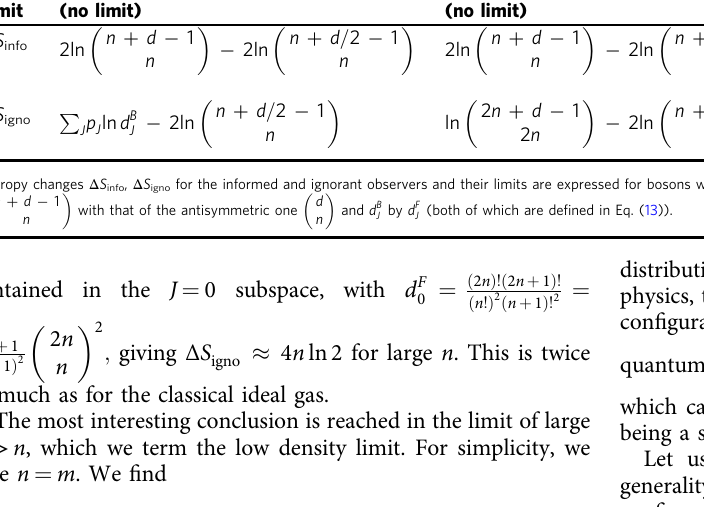
Table 2 Summary of results. Quantum Classical Quantum Quantum